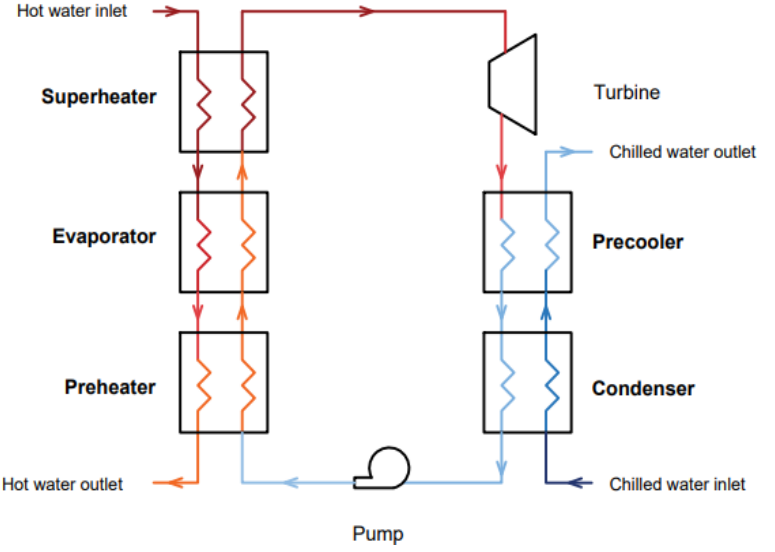
Figure 1. Organic Rankine Cycle (ORC) configuration with heat exchanger sections.